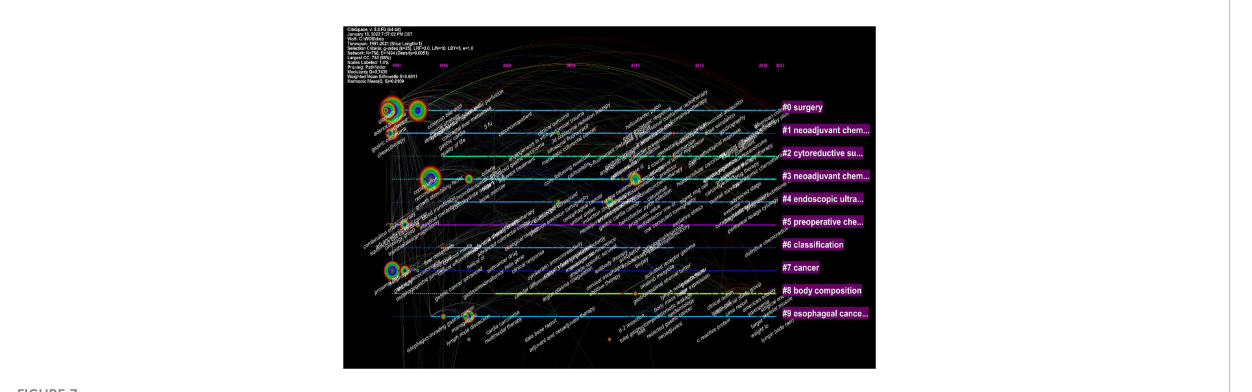
FIGURE 7 Visualization map of the timeline viewer of the studies related to neoadjuvant chemotherapy for GC from 1991 to 2021.